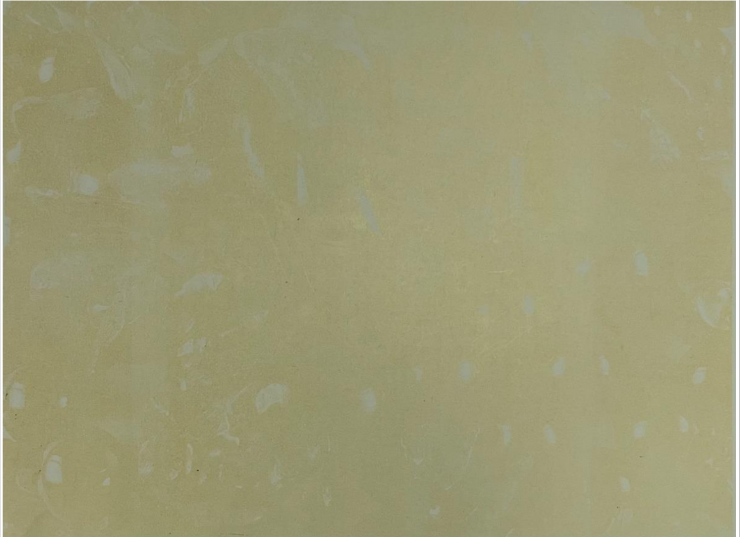
Figure A5. 25LPI, direct litho, Iriodin™ Solar Gold on yellow plate, white Plike, film positive, print size: 600 mm × 450